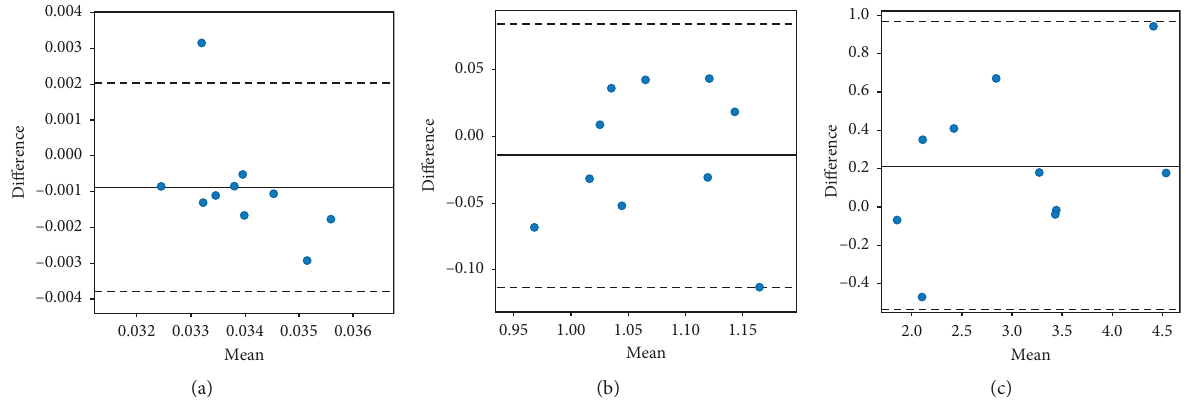
Figure 9: The Bland–Altman plot of the mice bone spectra (manual method-automatic method values). The straight line is the mean of the differences. The dashed line is the mean of the differences plus or minus 1.96 ∗ SD, representing the limit of agreement. 90% of Crystallinity Index values, 100% of Mineral Maturity values, and 100% of Collagen Maturity values are within the dashed lines. Shifts of − 0.0009 cm for the Crystallinity Index, − 0.01 for the Mineral Maturity, and 0.21 for the Collagen Maturity are observed.